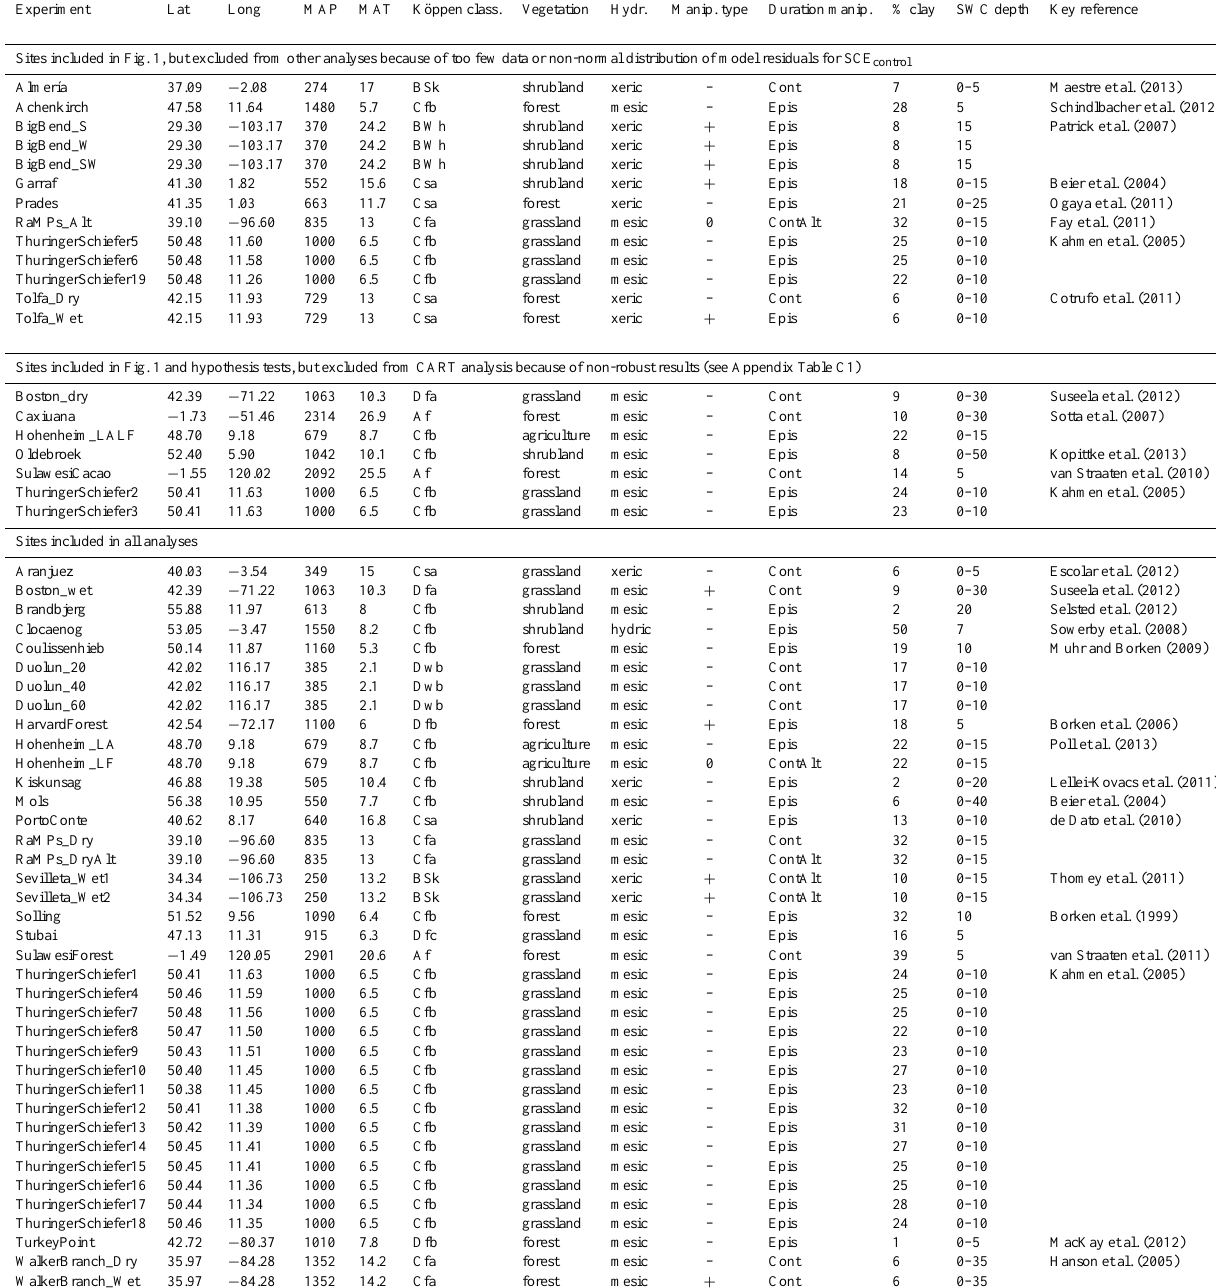
Table A1. Information about the precipitation manipulation experiments: latitude (Lat), longitude (Long), mean annual precipitation (MAP, mm), mean annual temperature (MAT, ◦ C), Köppen classification (Köppen class.), vegetation type hydrology (Hydr.), manipulation type (Manip. type: drying experiment (–), irrigation experiment ( + ) or experiment in which the pattern of precipitation was altered, but not the total amount of precipitation (0)), duration of the manipulation (episodic manipulation over a few weeks while the rest of the year is unaltered (Epis) versus continuous drying/irrigation during entire growing season or year (Cont) versus altered rainfall pattern during entire year (ContAlt)), the percentage of clay in the soil, the depth of SWC measurements (cm), and a key reference for each experiment (if available). Species composition for all sites is given in Supplement Table S1. We distinguish between sites used only for Fig. 1 (not used for further analysis because there were not enough data points to generate reliable model fits ( n ≤ 10)), sites discarded from further analyses because of non-robust results (see Appendix Table C1), and sites used for all analyses.